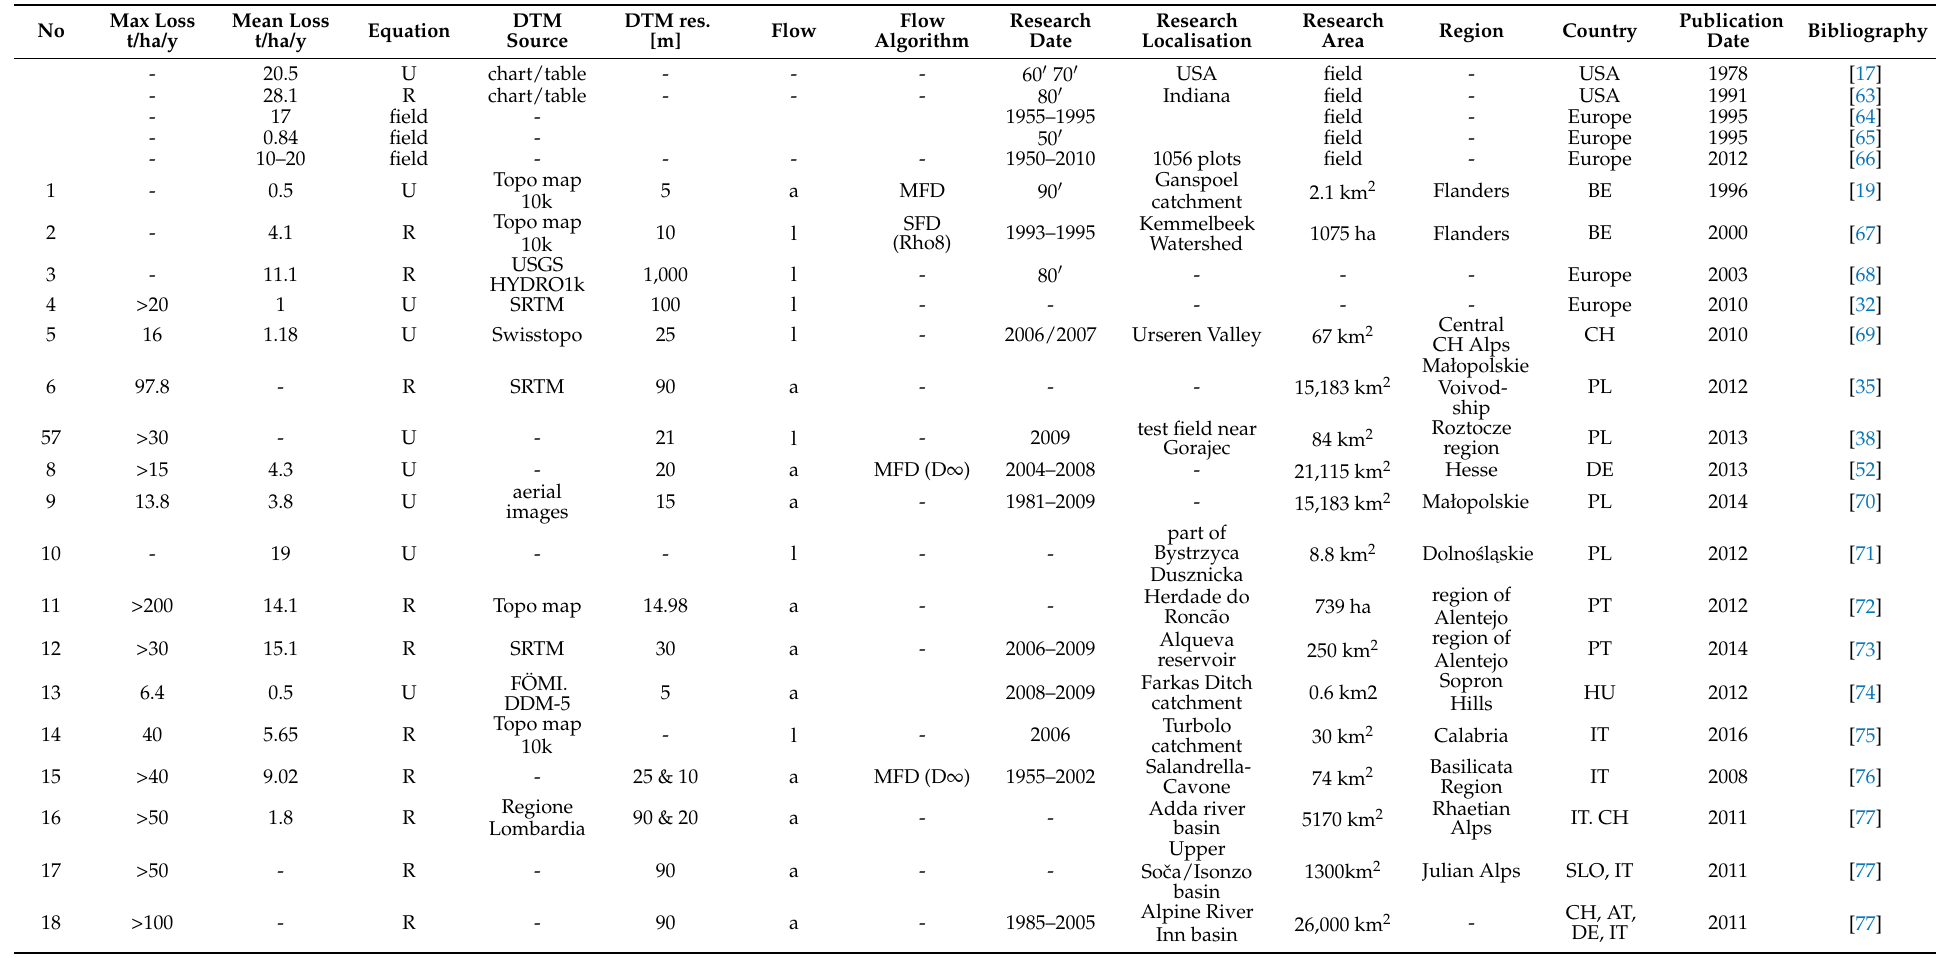
Table 1. Review of soil loss results from selected European studies in the period 1996–2020, and a comparison with the results of field studies from USA and Europe investigations. Equation: U (Universal Soil Loss Equation (USLE)) and R (Revised Universal Soil Loss Equation), flow: flow length (l) and unit contribution area (a) and flow algorithm: single flow direction (SFD) and multiple flow direction